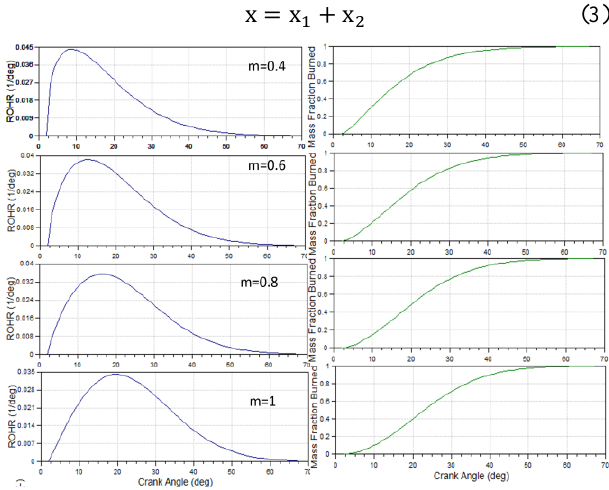
Fig. 5. First Vibe curve to model combustion and heat release in the cylin- der, and influence of m (shape